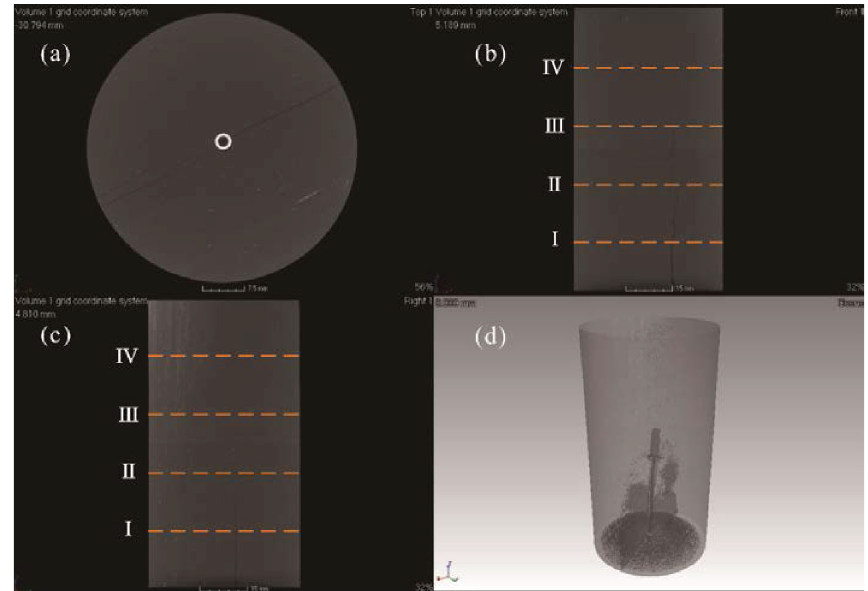
Figure 7: Micro-CT scanning results of rock sample H2. (a) A horizontal slice. (b, c) Two vertical slices near the sample center and are cut roughly perpendicular to the fractures, and I-IV correspond to the horizontal slices at heights of 20mm, 40 mm, 60mm, and 80mm. (d) The 3D view of the scanning